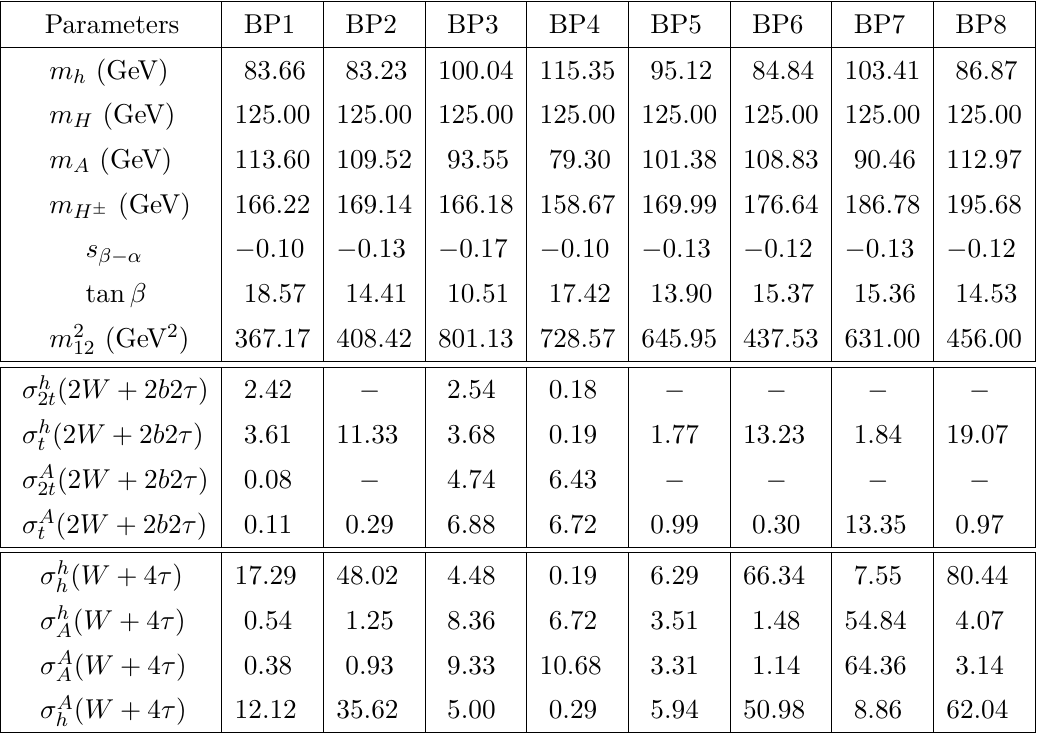
Table 6 . Mass spectra and mixing angles in the Type-X scenario, alongside cross sections (in fb) from different production channels, are